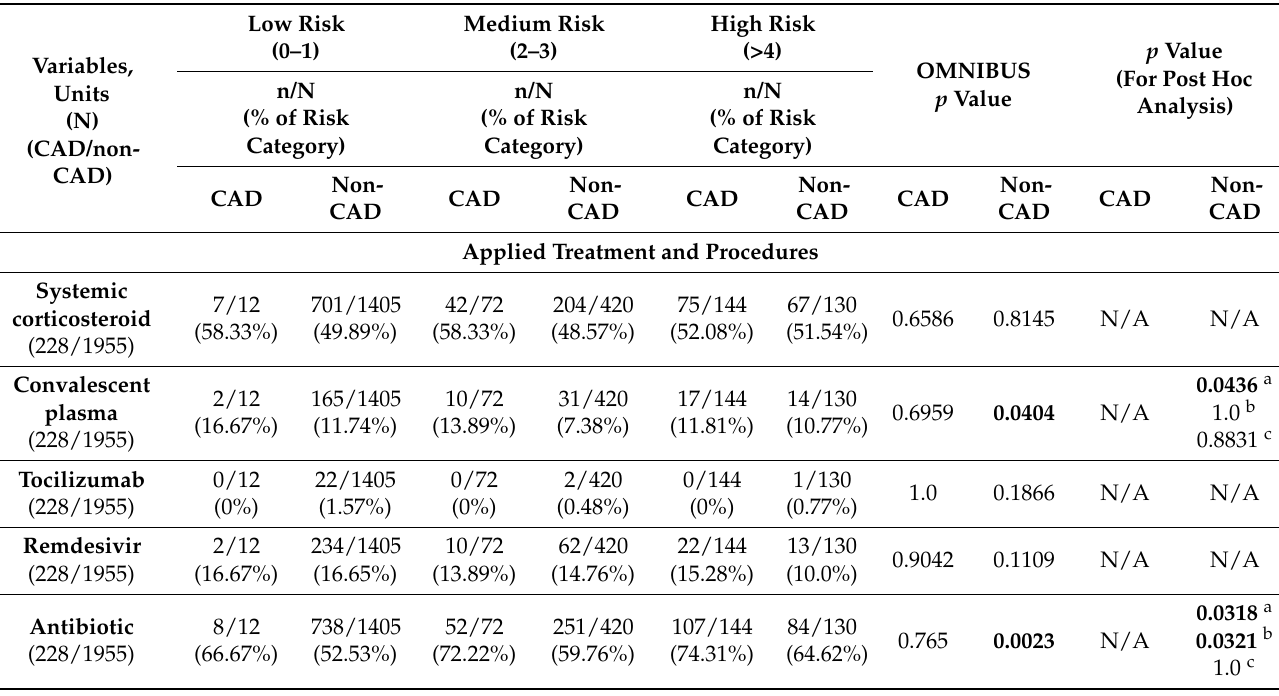
Table 5. Therapies applied during hospitalization in the studied cohort.